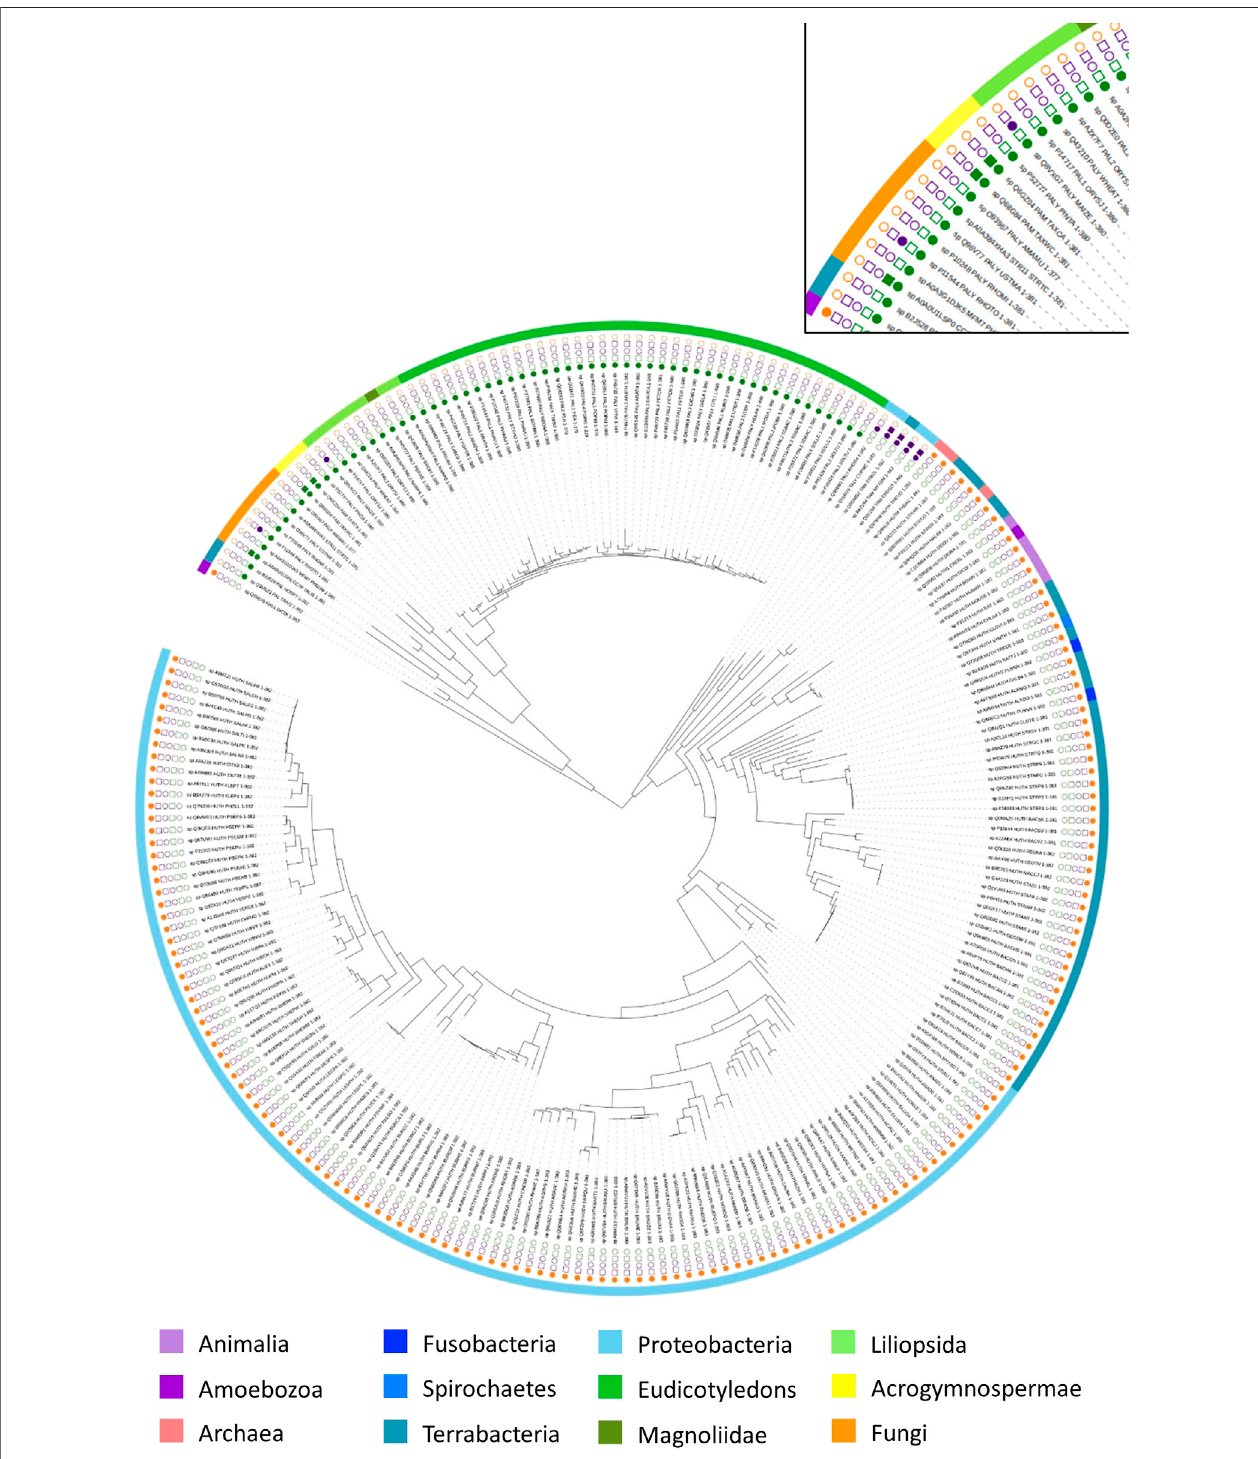
FIGURE 5 | Phylogenetic tree of arylalanine amino acid ammonia-lyase and aminomutase homologs retrieved from the Swissprot database. Characterized ammonia-lyases are shown in the square while characterized aminomutases are shown in the circle. The color coding corresponds to the substrates of the enzymes: histidine (yellow), phenylalanine (green), tyrosine (purple). The source organisms in the tree are color-coded in the outer ring according to their origin.